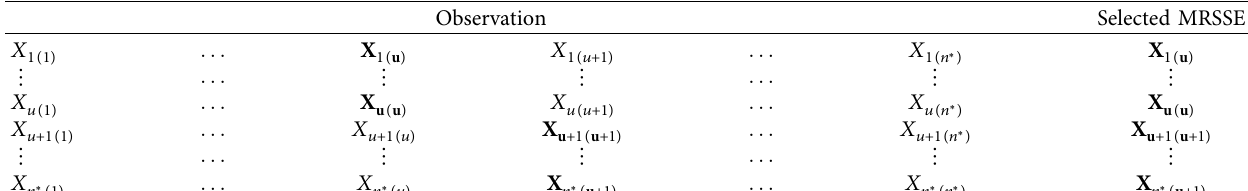
Table 3: MRSS with even set size